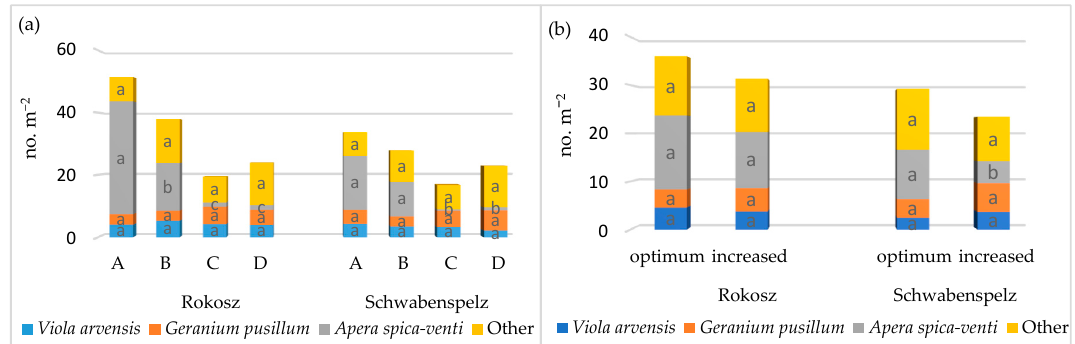
Figure 3. The impact of crop protection system on number of dominant weeds species at the dough stage (BBCH 83–85) in the spelt wheat cultivars “Rokosz” and “Schwabenspelz” (mean for 2013–2015). Different letters denote significant differences ( p ≤ 0.05) of number of weed species among different crop protection methods (A, B, C, D) ( a ) and seeding density ( b ). The same letter means not significantly different values.